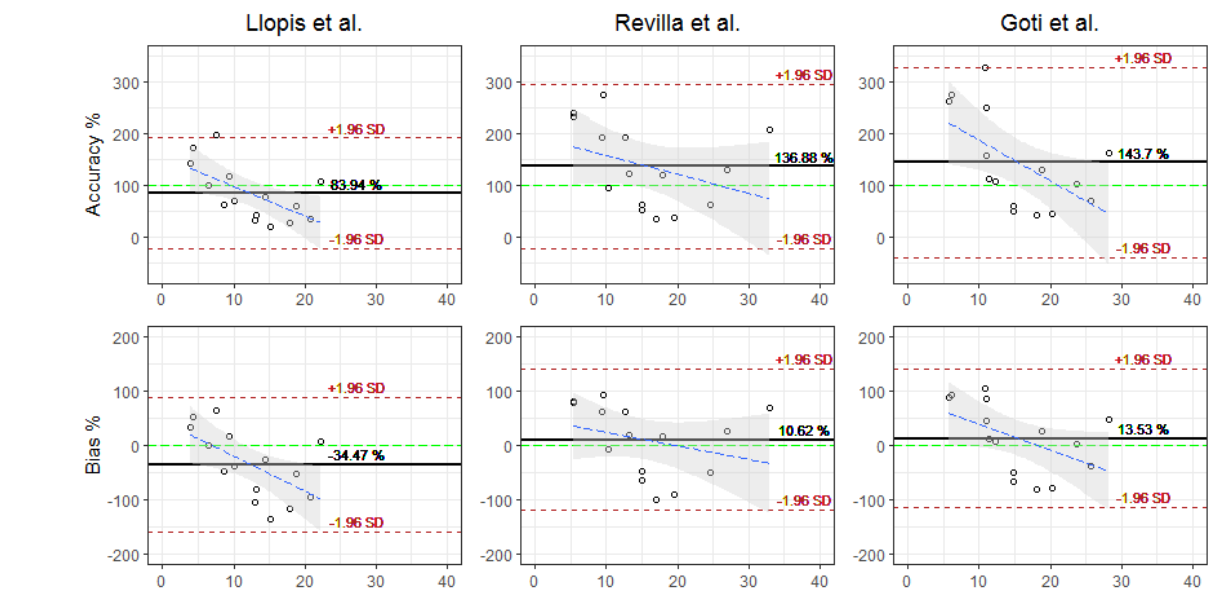
Figure 2. Bland – Altman plot for estimates. Figure 2. Bland–Altman plot for